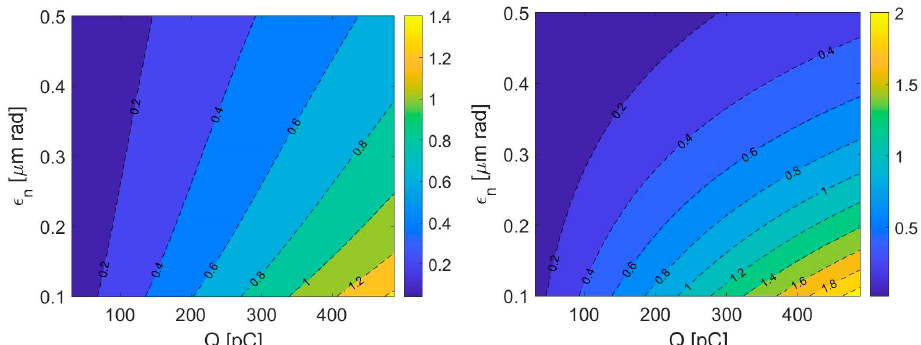
Figure 9. FEL pulse energy in mJ, as function of the beam normalized slice emittance and the bunch charge, at Table 2. keV (left) and 16 keV (right). The electron beam energy is, respectively, 2 and 5.5 GeV. The peak current is fixed to 4.5 kA in both cases.